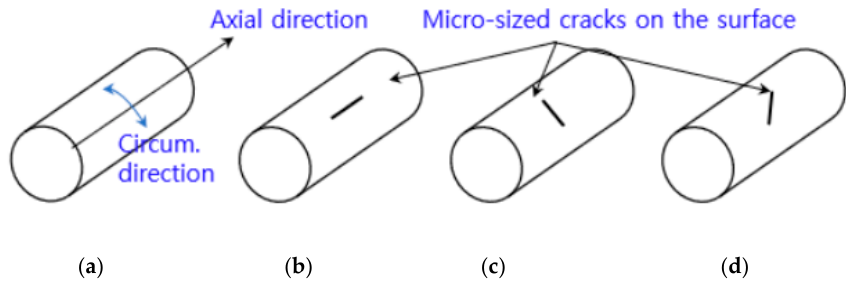
Figure 5. Overview of sample types with micro-sized defects; ( a ) Non-crack, ( b ) Axial crack, ( c ) Circum crack, and ( d ) Shear crack.